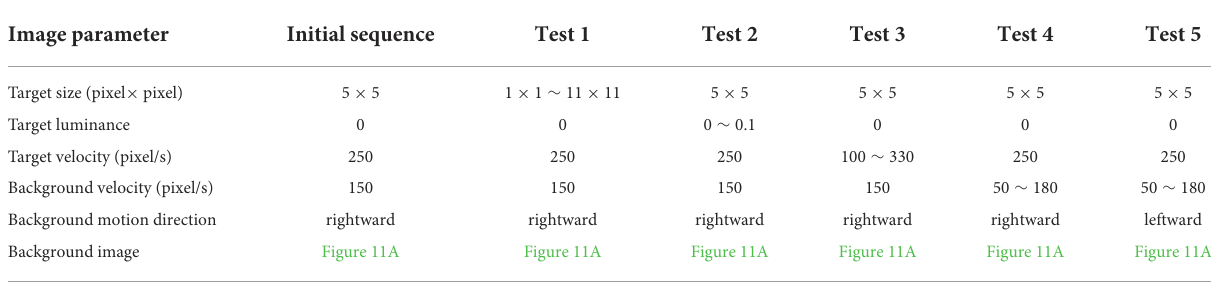
target luminance, target velocity, and background velocity when the false alarm rate is equal to 15. The detection results of the three models for different target sizes are displayed in Figure 12B. It can be seen that the detection rates of three models show a significant decrease after reaching the highest point when the target size increases from 1 1 to 11 11. × ×